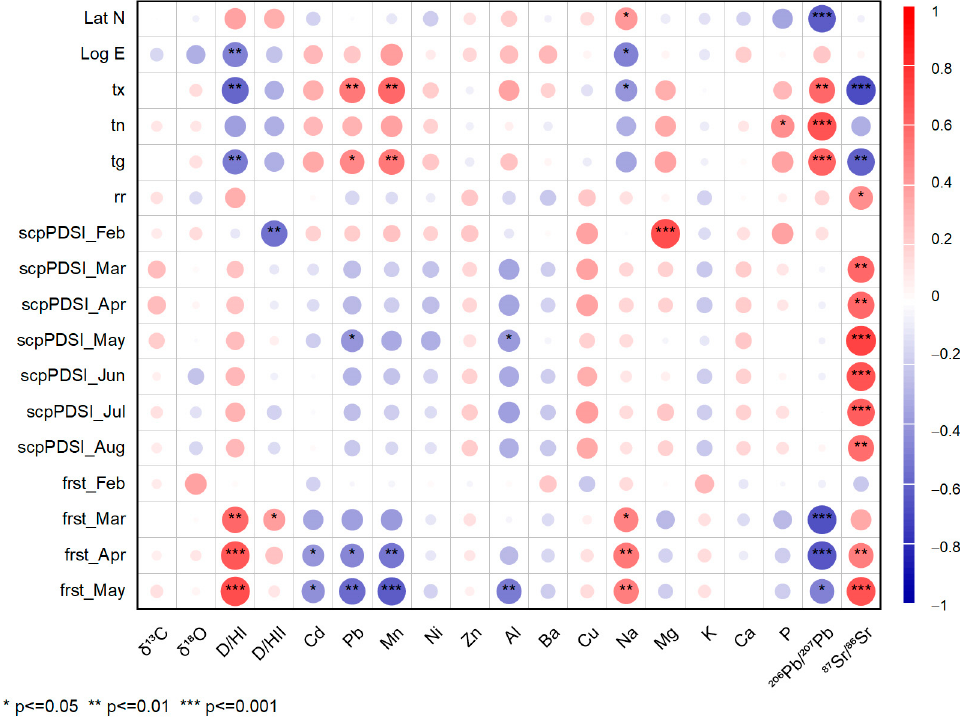
Figure 4. Pearson’s correlation coefficient matrix between the climate, geographical position, the year of capitalization, micro and macroelements, toxic elements, and isotopic ratios. The correlation intensity was illustrated from insignificant correlation coefficients (smaller circles and transparent colors) to significant ones (higher diameters and dark colors). The confidence interval of the significant values was presented di ff erentiated between 95%, 99%, and 99.9%.